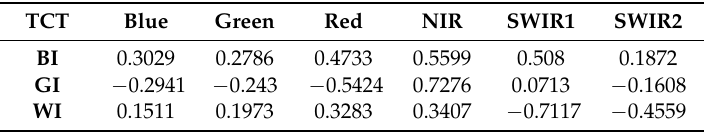
Table 3. TCT (tasseled cap transformation) coefficients of Landsat-8 imagery. BI: brightness index; GI: greenness index; WI: wetness index. TCT Blue Green Red NIR SWIR1 SWIR2 BI 0.3029 0.2786